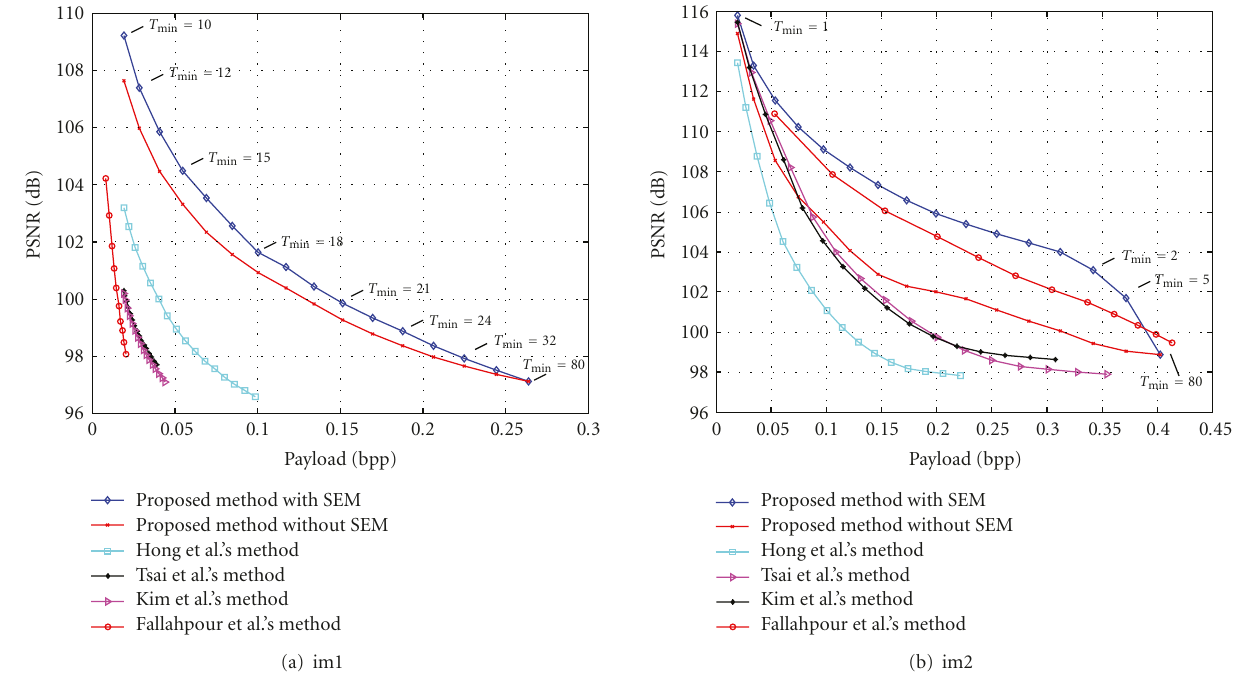
Figure 12: PSNR versus payload of two medical images.